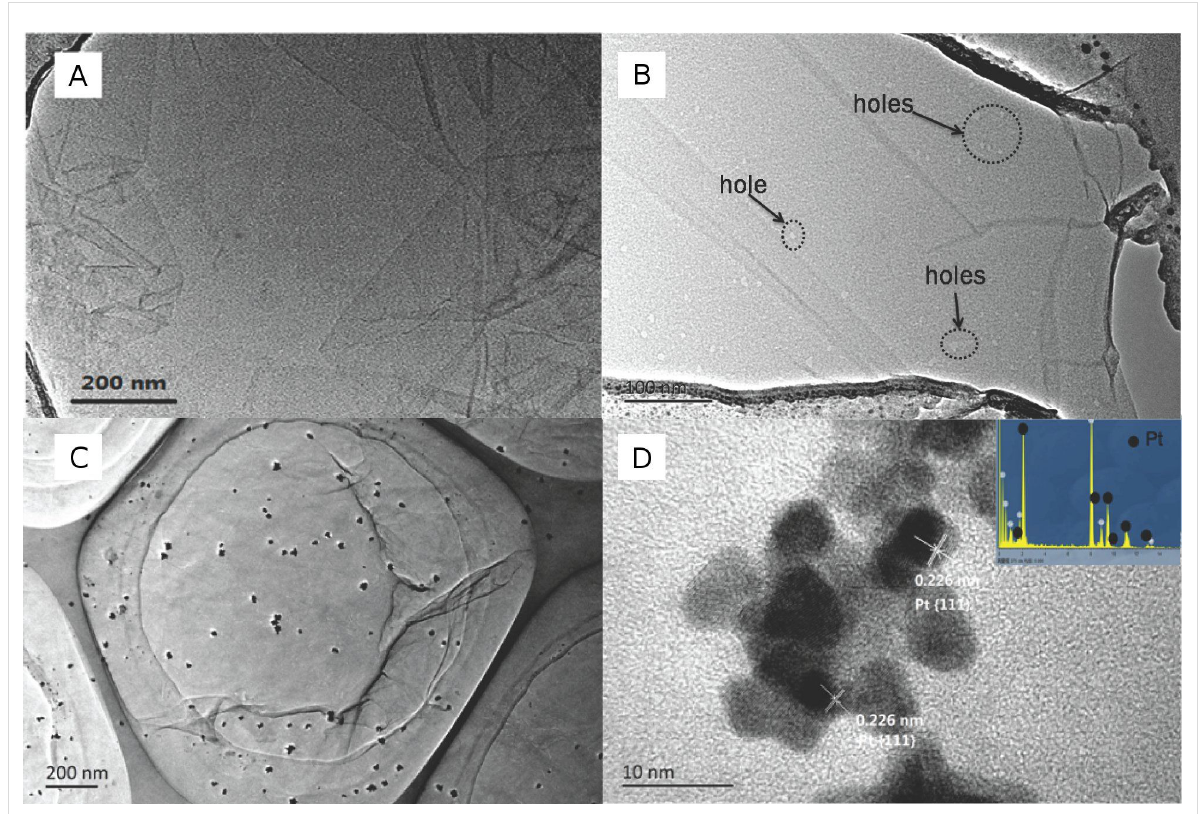
Figure 9: TEM images of GO (A), RGO24 (B), RGO24 with deposited Pt (C), and HRTEM image of deposited Pt (D). The inset of Figure 9D is the EDS spectrum.